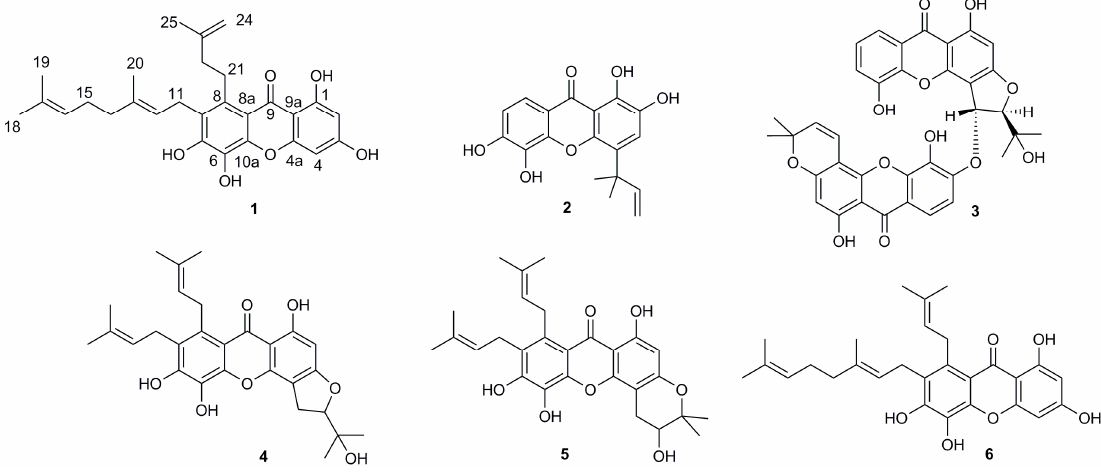
Figure 1. Structures of compounds 1 – 6.